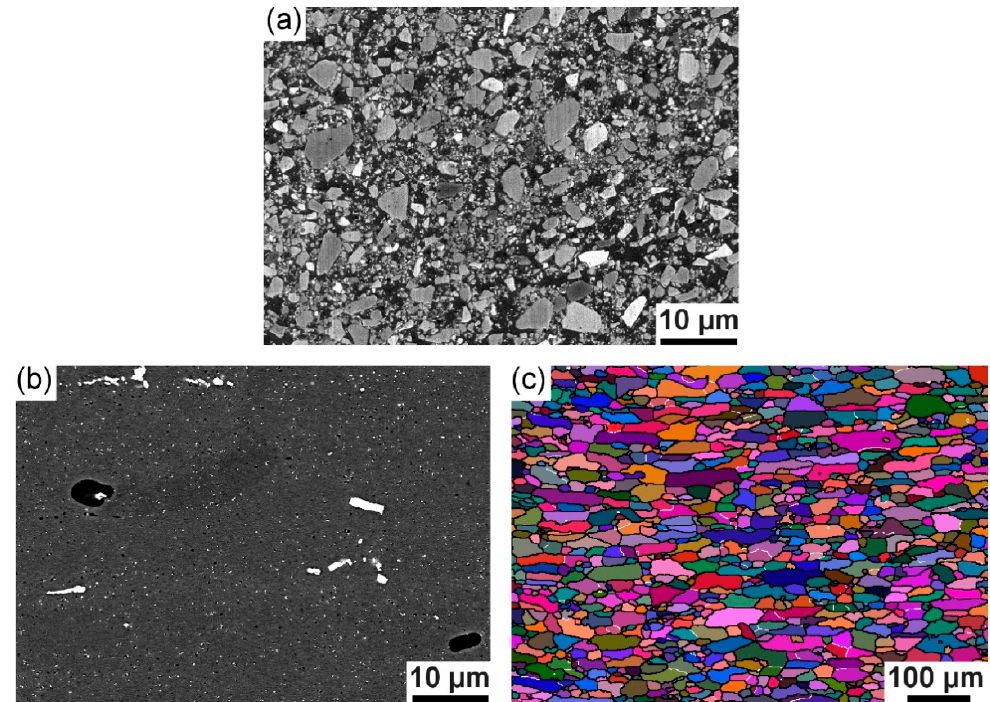
Figure 2. Microstructure in the cross-section of the as-received plates: ( a ) secondary electron image of the MMC plate; ( b ) BSE image; ( c ) orientation map for the AA6061 plate. In ( c ), LABs and HABs are shown as white and black lines, respectively. The normal direction is vertical.